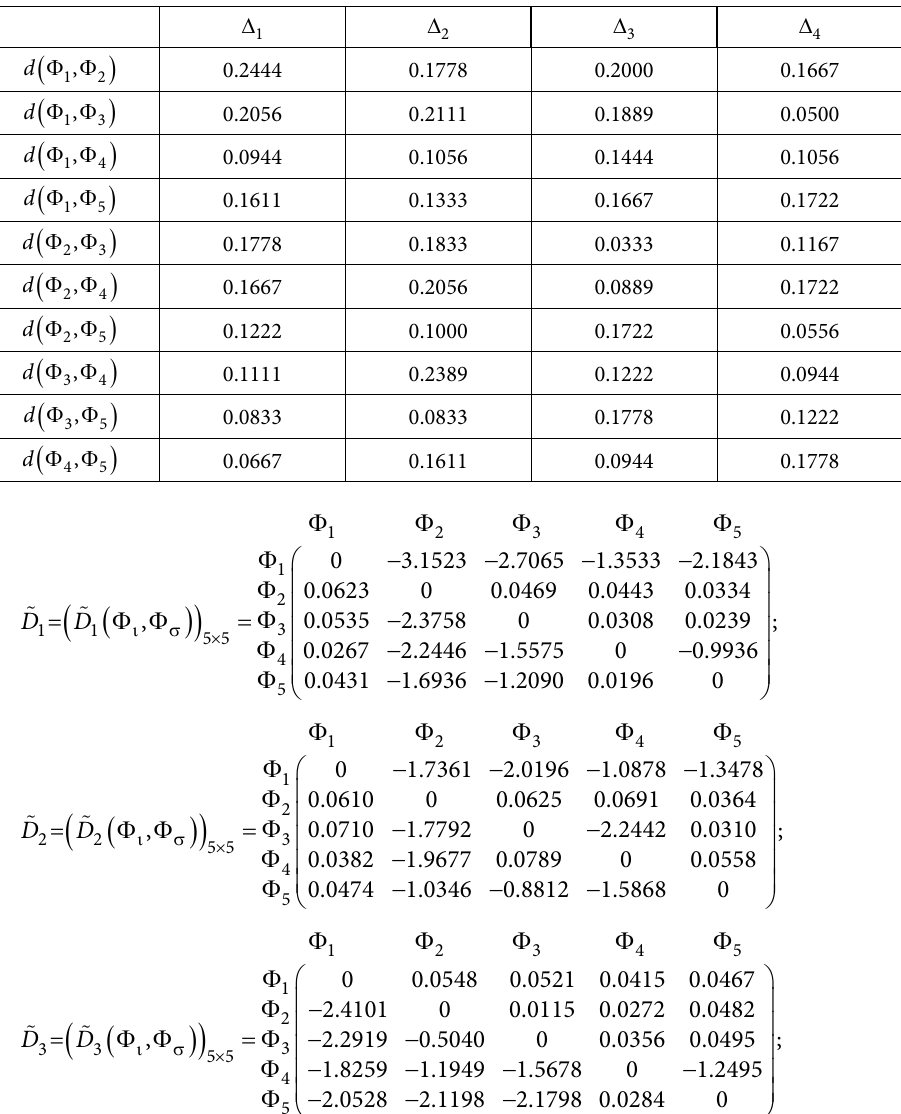
Table 13. Distance between each two